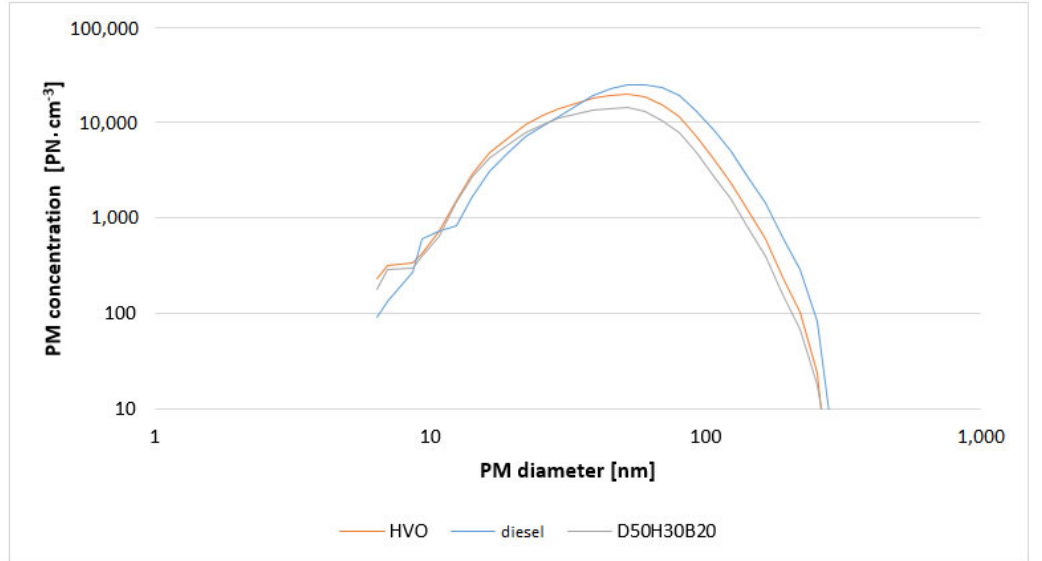
Table 10. Total PM production in NEDC driving cycle.